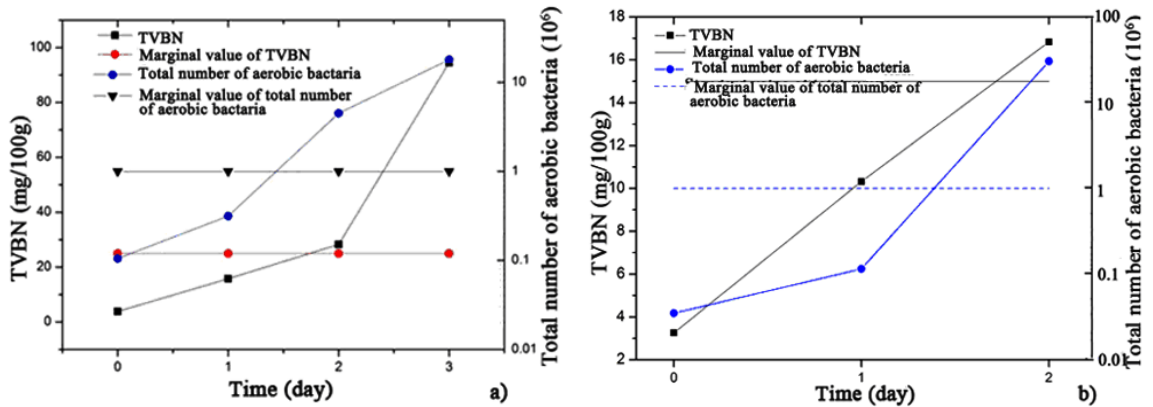
Figure 4. Changes in the TVBN and total number of aerobic bacteria during storage for hairtail fish ( a ) and pork ( b ).